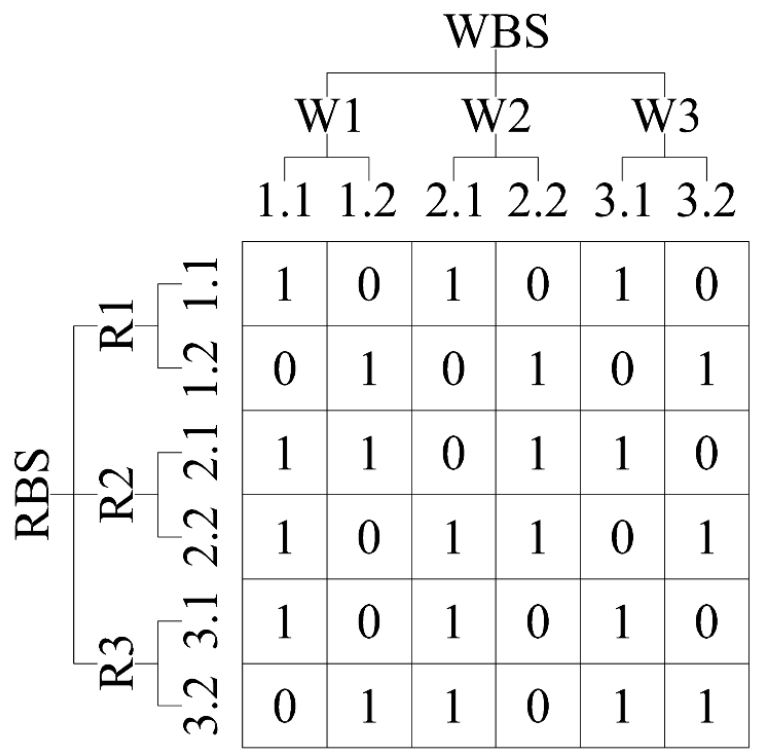
Figure 5. WBS-RBS coupling Figure 5. WBS ‐ RBS coupling matrix.